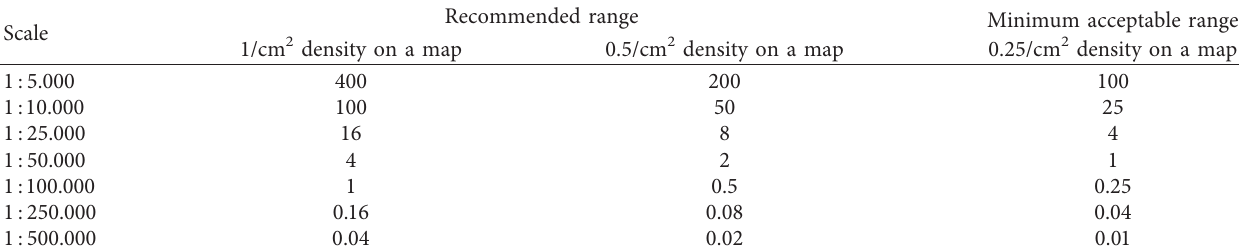
Table 1: Soil sampling density per km 2 mapping